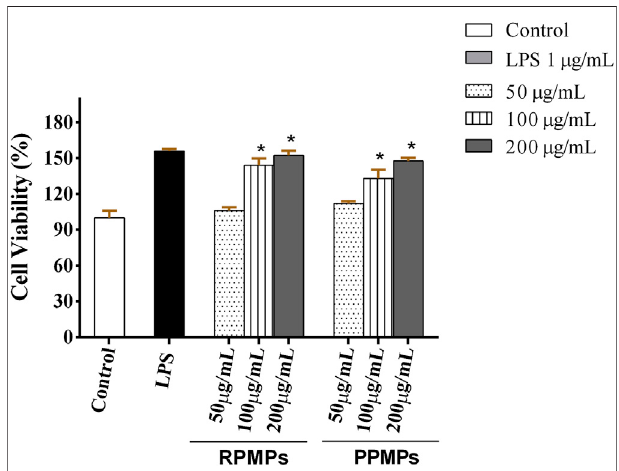
FIGURE 6 | Effects of RPMPs and PPMPs on the viability of RAW 264.7 cells. Results are represented as mean ± SD, n = 6. * p < 0.05 denotes a statistically signi fi cant difference between the treated and control groups.